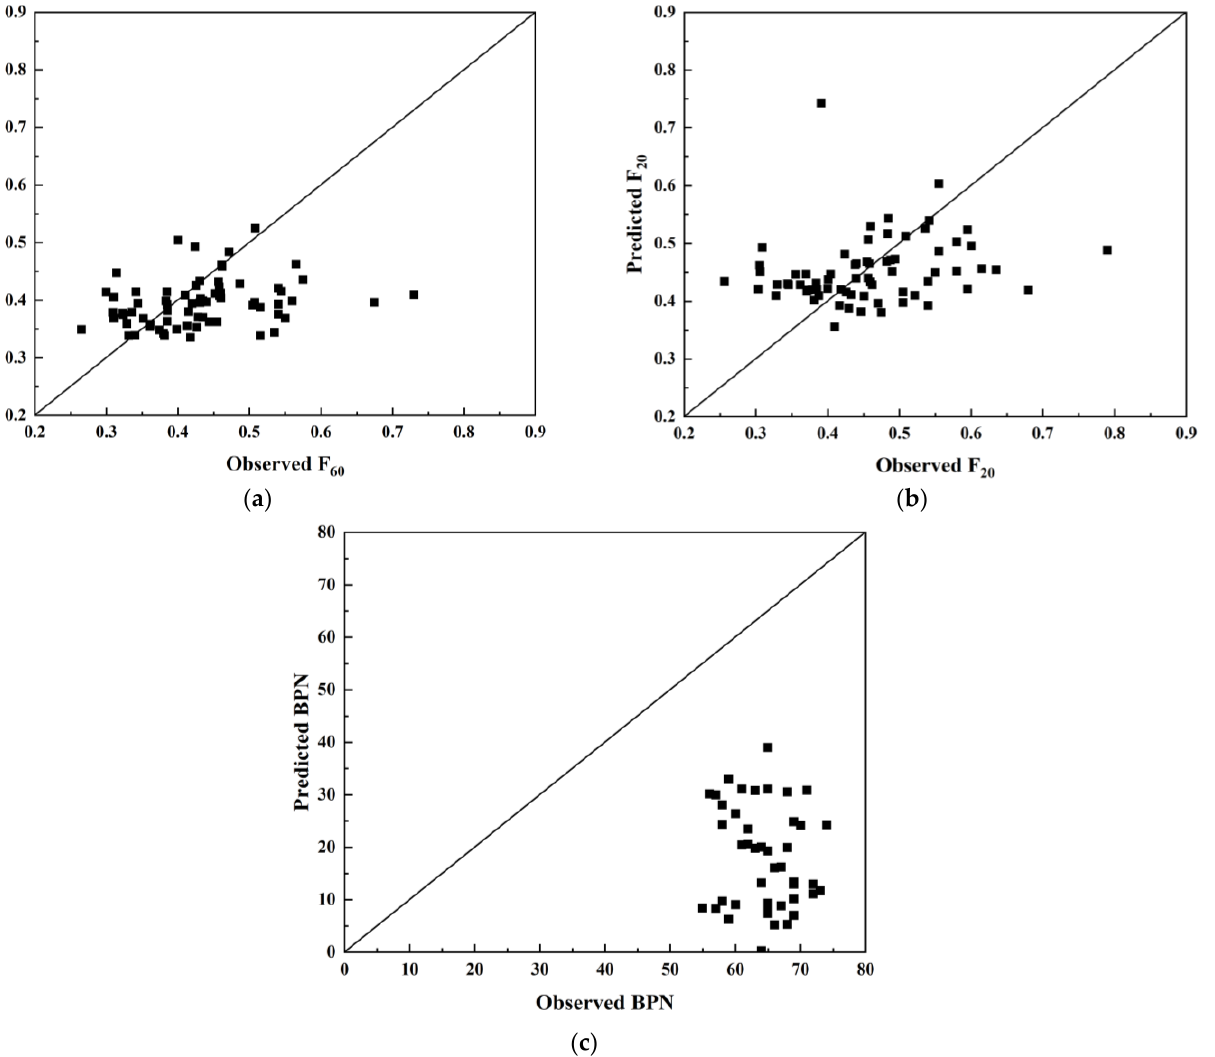
Figure 7. Scatterplots of the measured and predicted skid resistance: ( a ) F 60 , ( b ) F 20 , and ( c )